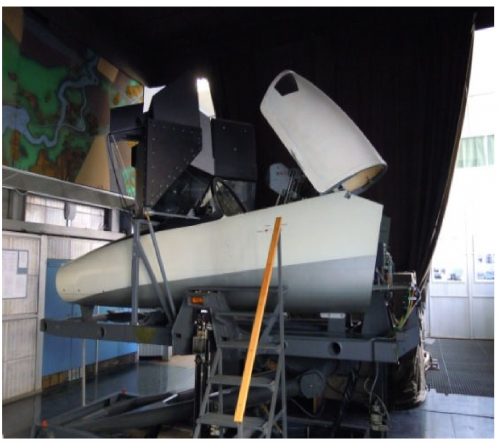
Figure 7. Ground-based